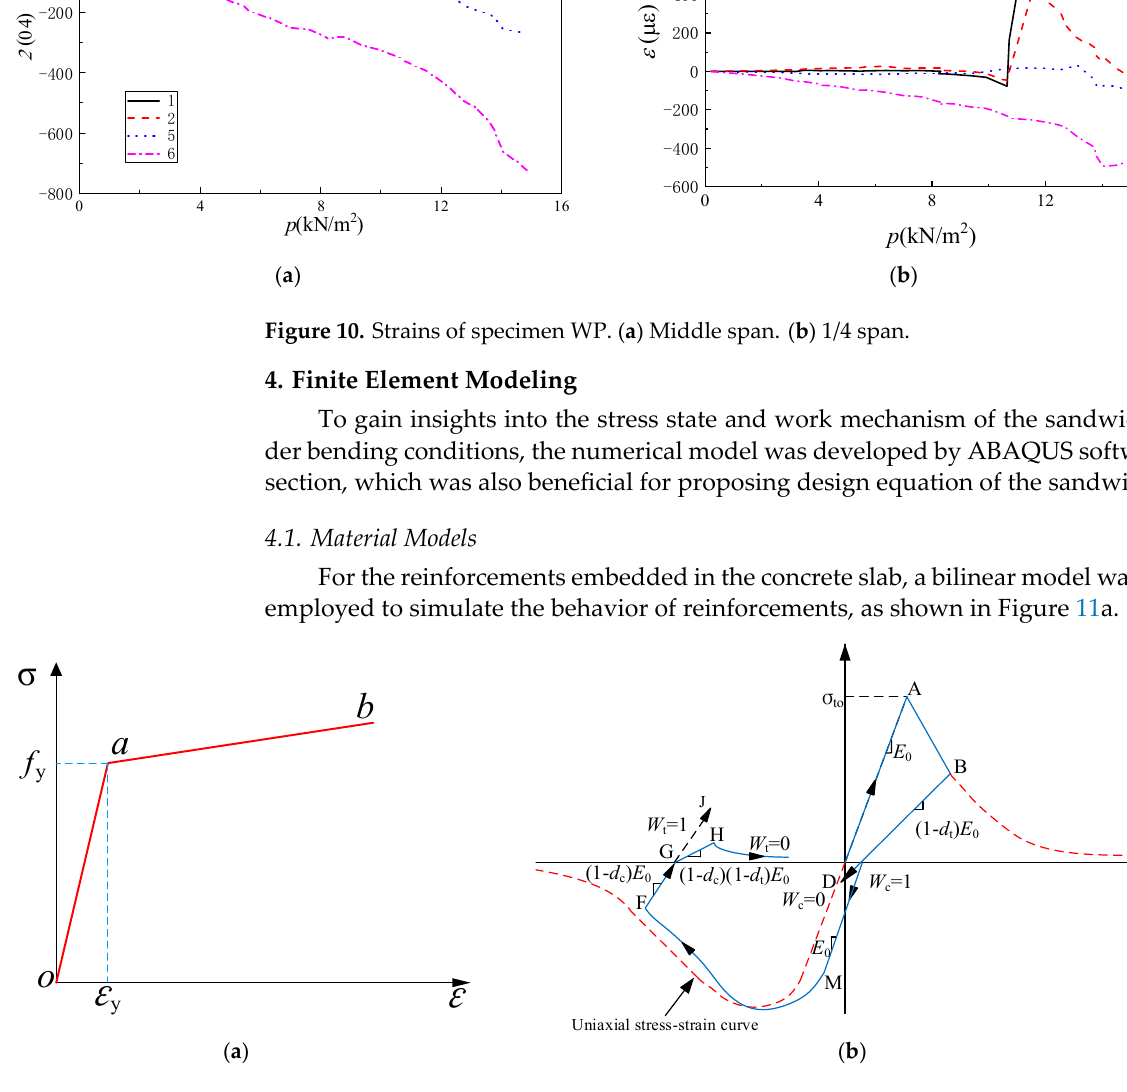
Figure 11. Material models of concrete and reinforcements. ( a ) Reinforcements. ( b ) Concrete.